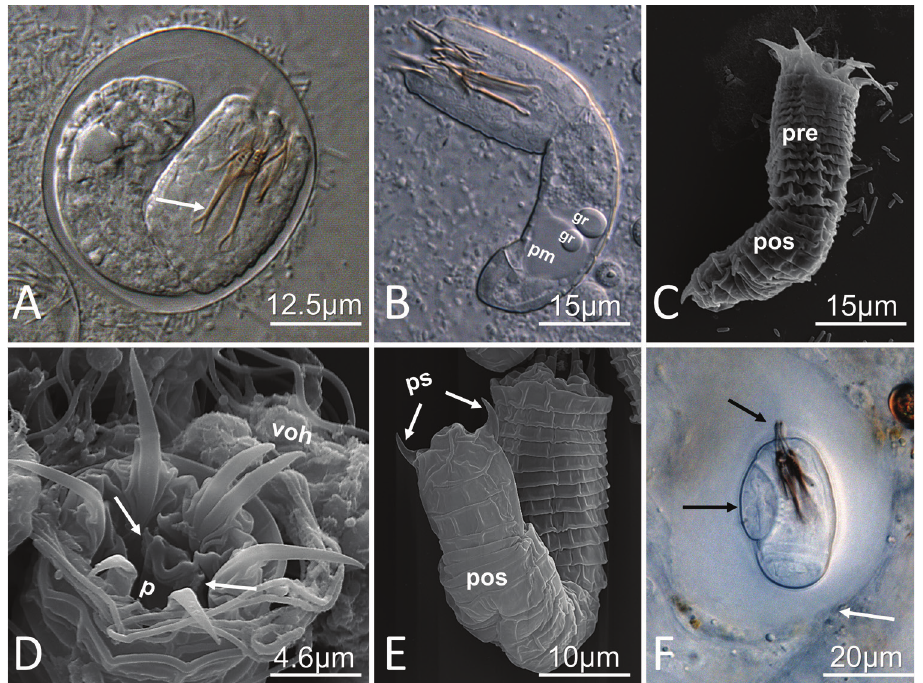
Figure 5. Egg, larva and cyst characteristics of Paragordius amicus sp. n. A DIC photomicrograph of an egg with a fully developed larva. Note the stylets (arrow) B DIC photomicrograph of a live larva. Note the pseudointestine composed of two anterior granules (gr) and posterior mass (pm) C SEM photomicrograph of larva. Note the distinct preseptum (pre) with relatively long outer hooks, and postseptum (pos) with posterior spines D SEM photomicrograph of the anterior end larva. Note the partially everted proboscis (p) with distinct spines on the left and right lateral sides (white arrows), and the outer row of hooks containing two ventral outer hooks (voh) E SEM photomicrograph of larva. Note two posterior spines (ps) on the dorsal side of the postseptum (pos) F DIC pho- tomicrograph of cyst (dorso-ventral view). Note the clear cyst wall (white arrow), distinct spines on the preseptum (black arrows), and the position of the posterior end of the postseptum (white